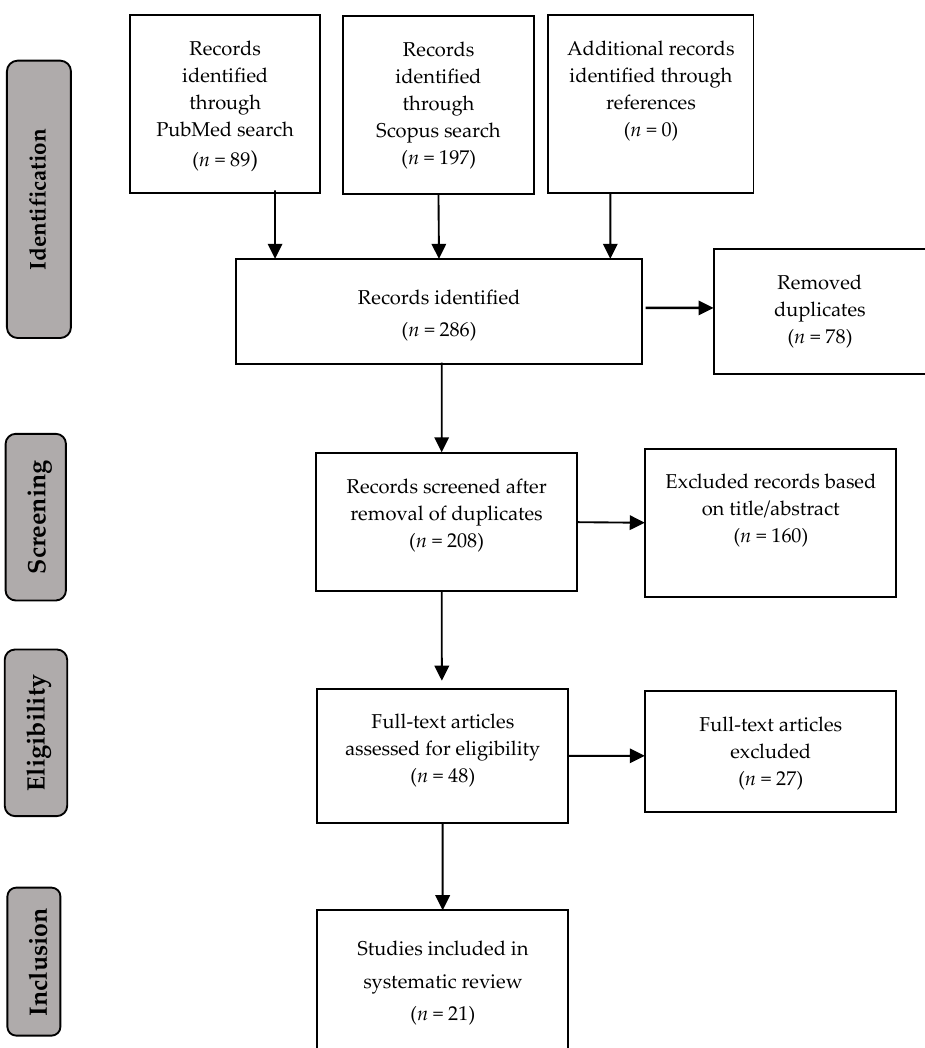
Figure 1. Search results. Figure based on Preferred Reporting Items for Systematic reviews and Meta- Figure 1. Searchresults. FigurebasedonPreferredReportingItemsforSystematicreviewsandMeta-Analyses Analyses (PRISMA) guidelines by Moher et al. [11]. (PRISMA) guidelines by Moher et al.